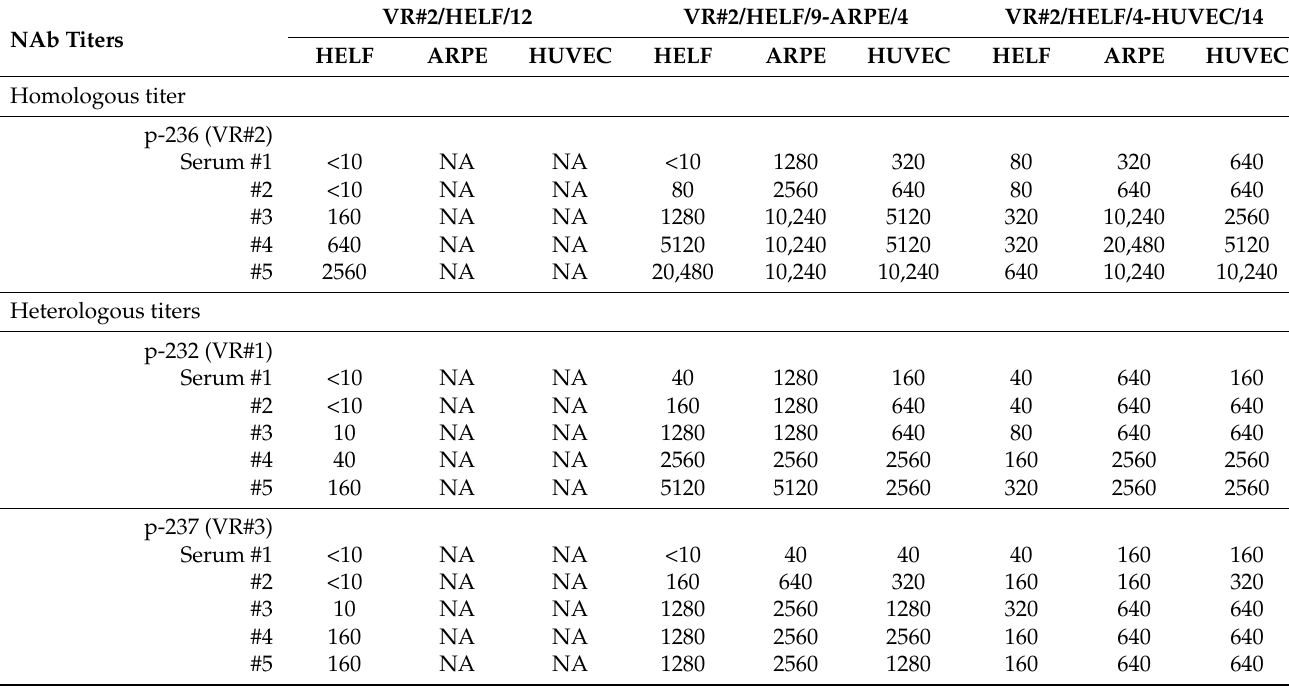
Table 2. Homologous and heterologous NAb titers of p-236 vs. VR#2 (homologous) and p-232 and p-237 vs. VR#2 (heterologous).